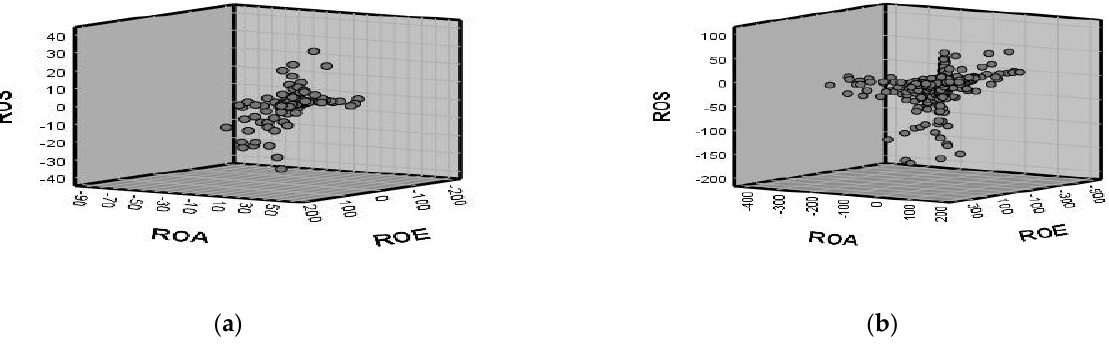
Figure 3. Link between financial performance indicators: ( a ) Hungarian companies. ( b ) Romanian companies. Source: Authors ’ own editing, based on own calculations.